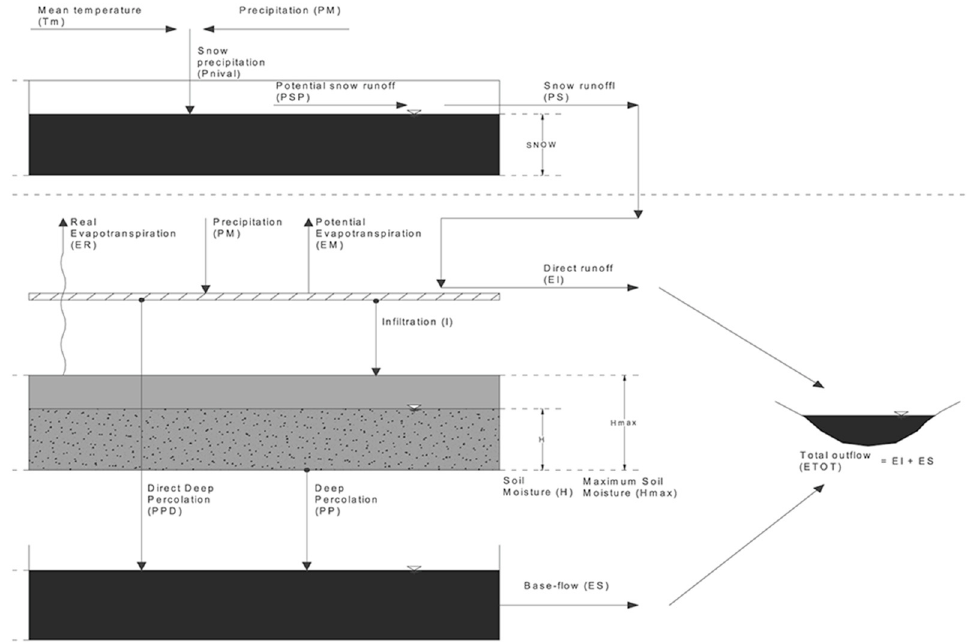
Figure 4. Conceptual diagram of the Muñoz Hydrological Model (MHM) model.